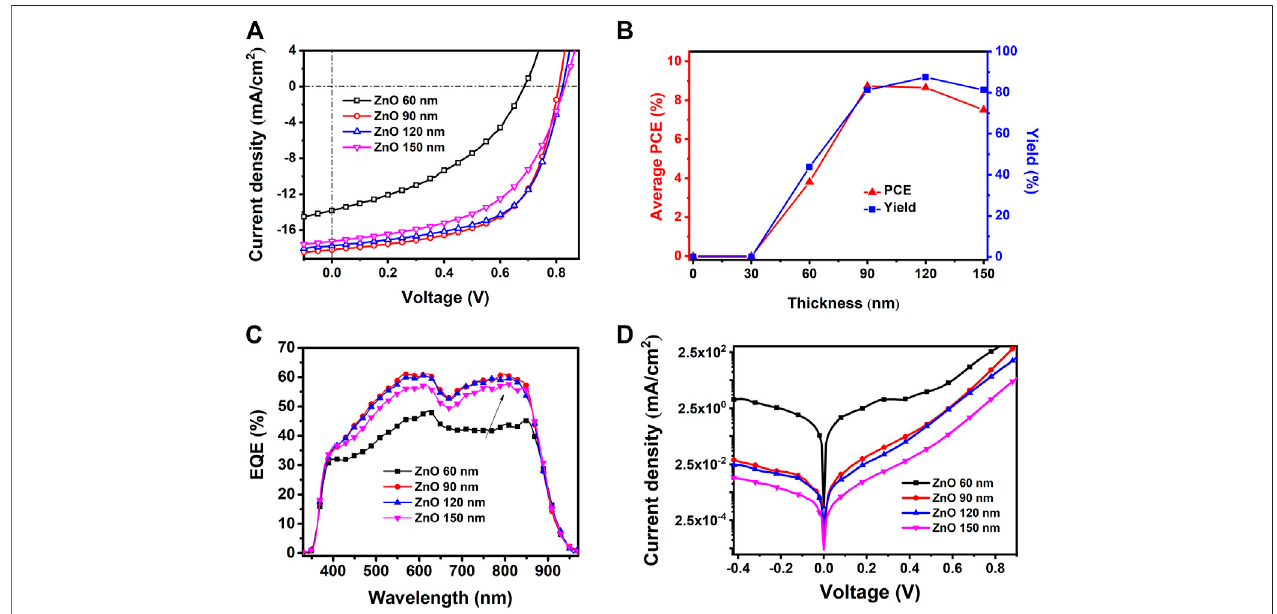
FIGURE8| Performanceofspray-coateddevicesbasedonAgNWs/ZnO fi lmsofdifferentZnOthicknesses. (A) J – Vcharacteristicsunderirradiation, (B) yields, (C) EQE curves, and (D) J – V characteristics of the samples in the dark.